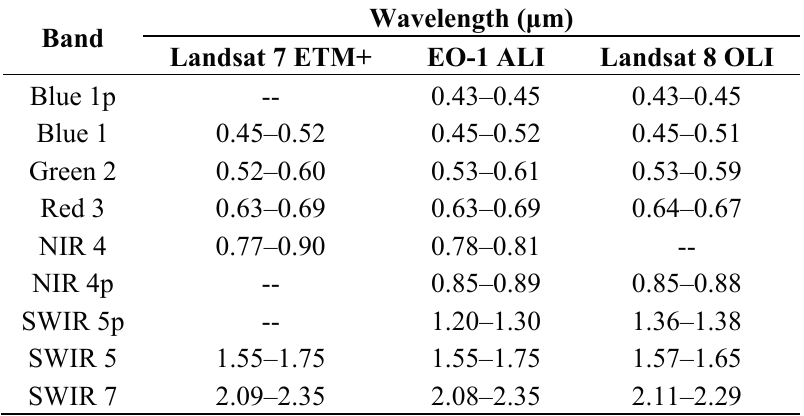
Table 1. Comparison of Landsat 7 ETM+, EO-1 ALI and Landsat 8 OLI reflective spectral bands. The band names follow the ALI naming conventions. NIR = near-infrared band, SWIR = short-wave infrared